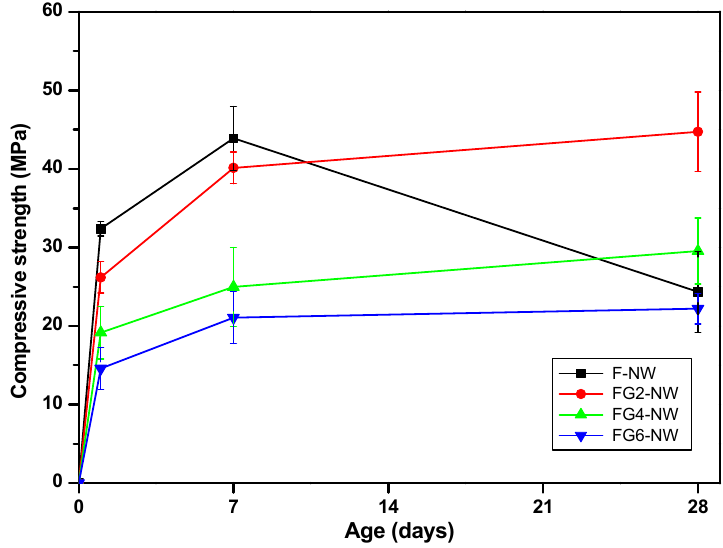
Figure 1. Compressive strength testing results of the samples containing different replacement ratios of gypsum. The labels “F”, “G”, “N” and “W” represent the fly ash, gypsum, NaOH and Na-silicate solution. F-NW: case of no gypsum addition; FG2-NW: 2% gypsum addition; FG4-NW: 4% gypsum addition; FG6-NW: 6% gypsum